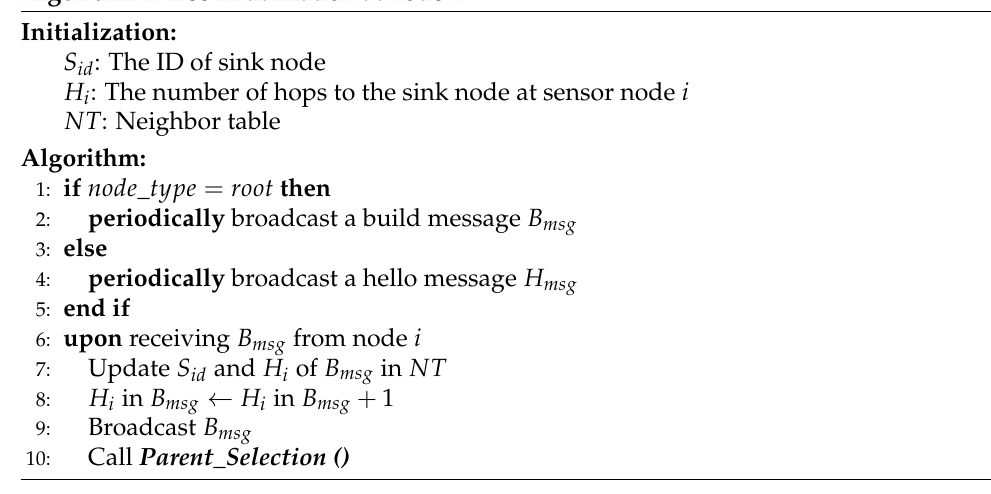
Algorithm 1 Tree initialization at node k